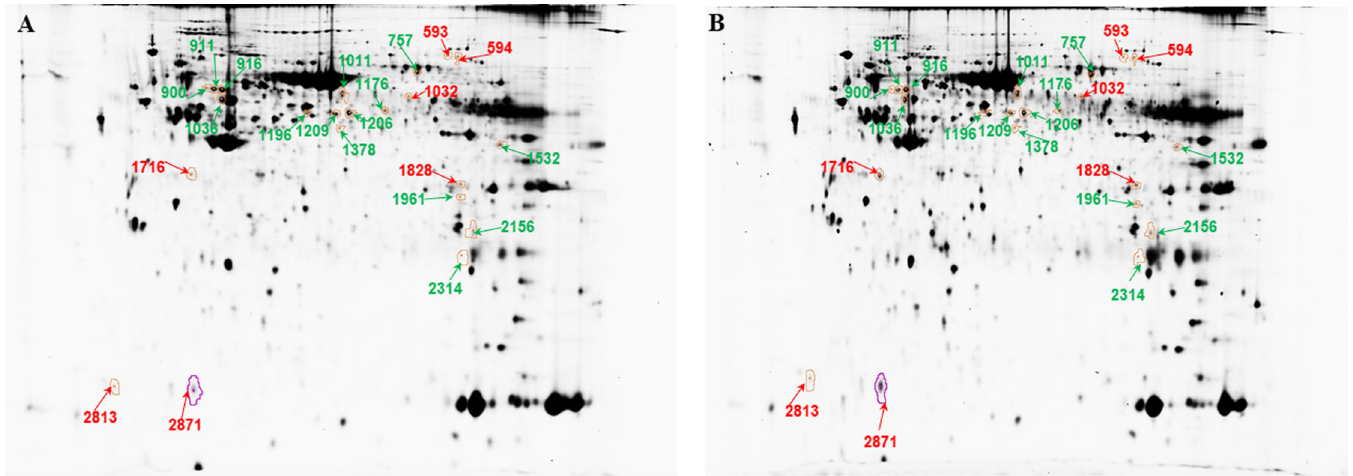
Fig 1. Representative 2D-DIGE profiling of differentially expressed proteins in the margin and center of ADC tumor. (A) single-channel image of proteins from tumor margin, (B) single-channel image of proteins from tumor center. Red numbers indicate proteins that are more abundant in center and green numbers indicate proteins with more abundance in margin. Twenty-two spots for ADC (numbers correlate with descriptions in S1 Table) with significantly different abundance between the margin and center of tumor are shown (p < 0.05).